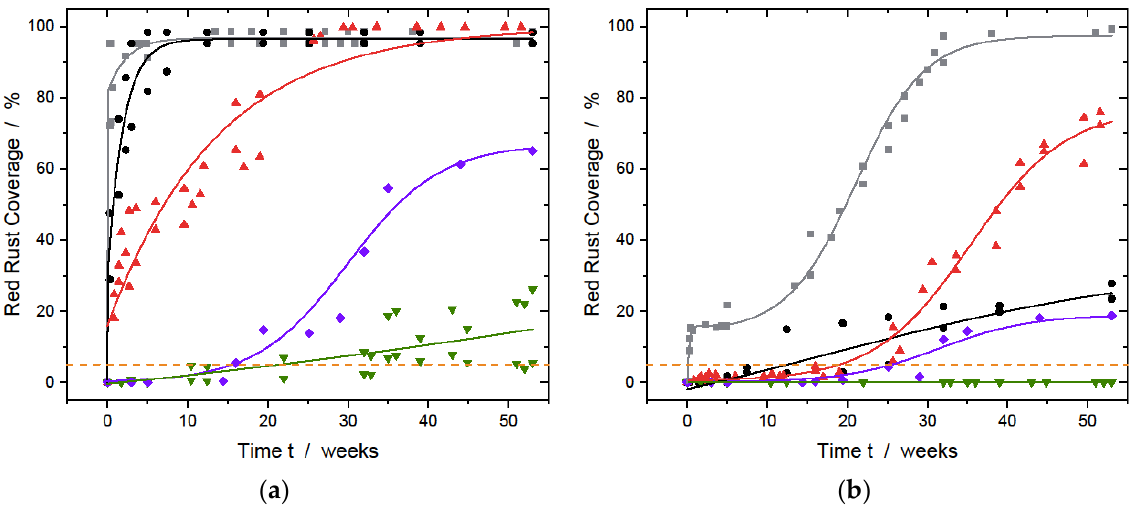
Figure 9. Red rust coverage over time of steel sheets without coating ( ■ ) and with Al (●), AlCr ( ▲ ), AlZn ( ▼ ) and AlSn coating ( ♦ ) for ( a ) the scratched area and ( b ) the whole sample surface. The lines represent the respective qualitative trend lines of the red rust coverage over time. The horizontal dashed lines (- - -) mark a red rust coverage of 5%.